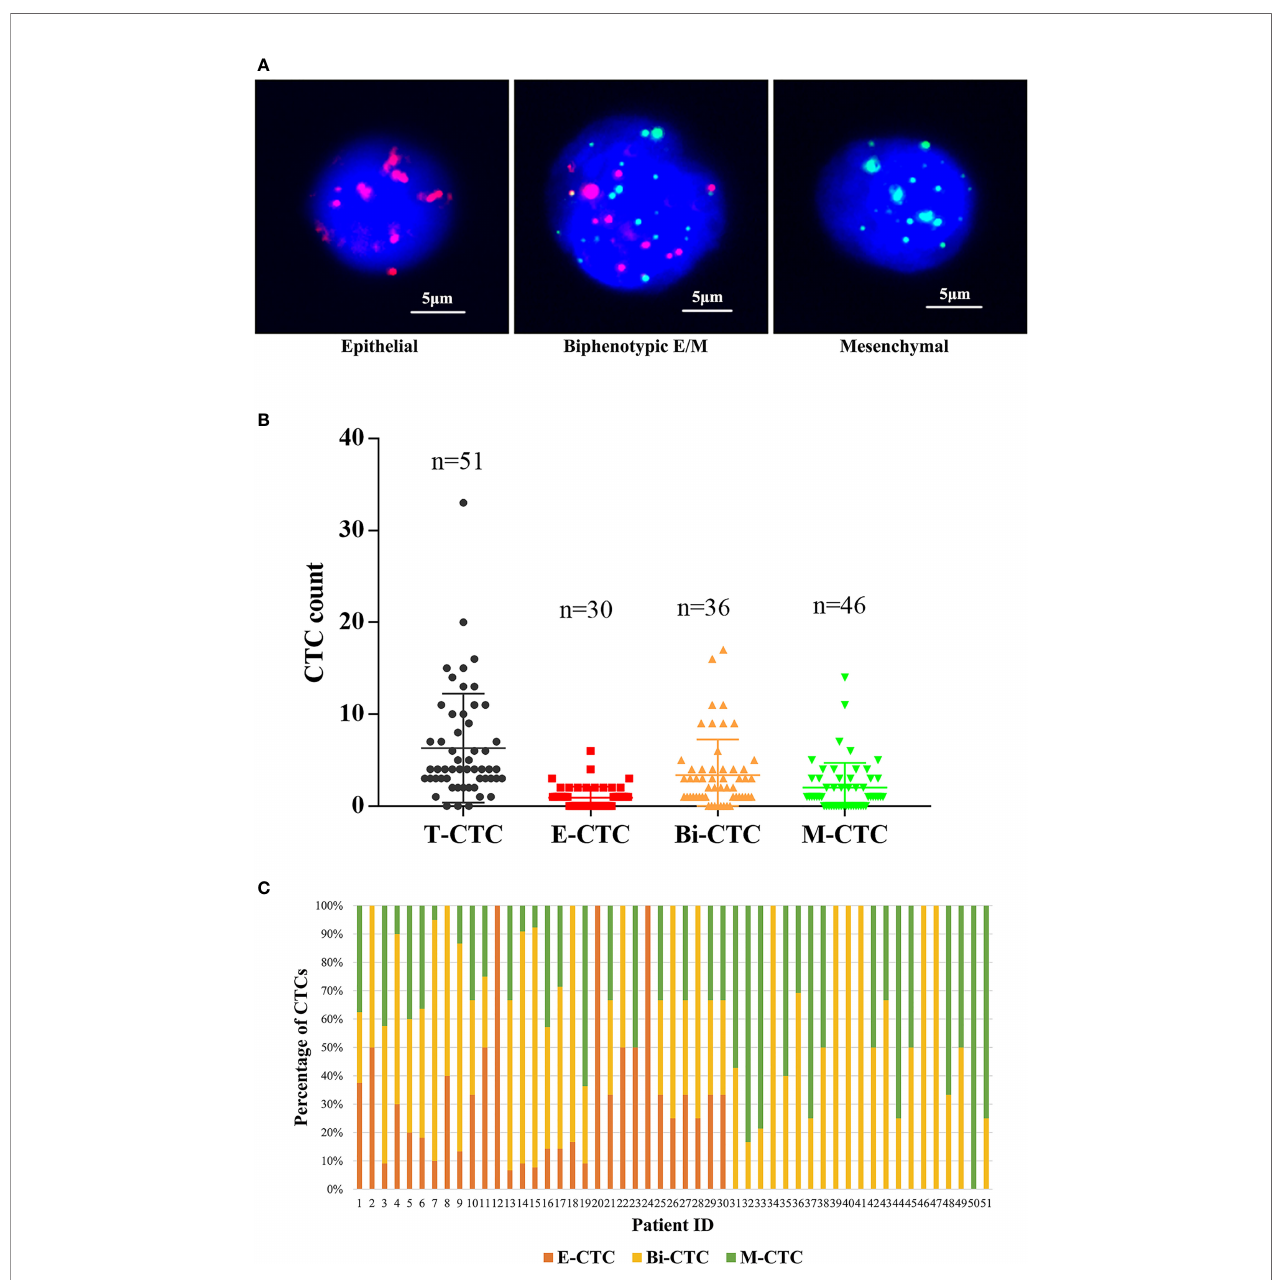
FIGURE 2 | (A) Representative fl uorescence images of three types of CTCs isolated from the peripheral blood of omHSPC patients based on RNA-ISH staining for leukocytes (CD45, white), epithelial cells (EpCAM and CK8/18/19, red), and mesenchymal cells (vimentin and twist, green). 4´,6-Diamidino-2-phenylindole was used to stain cell nuclei (blue). The scale bar indicates 5 m m. (B) Levels of CTC subtypes. (C) The distribution of three subtypes of CTCs in each